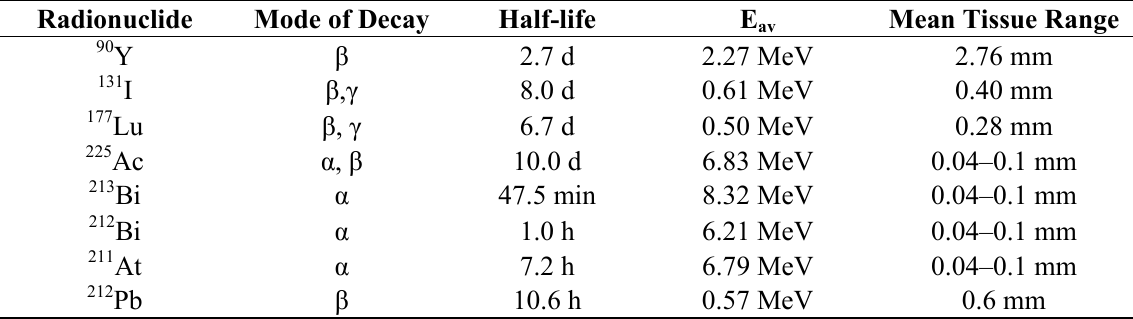
Table 4. List of radionuclide currently used in radiotherapy and their nuclear properties. As visible, all decay via α - or β -particulate